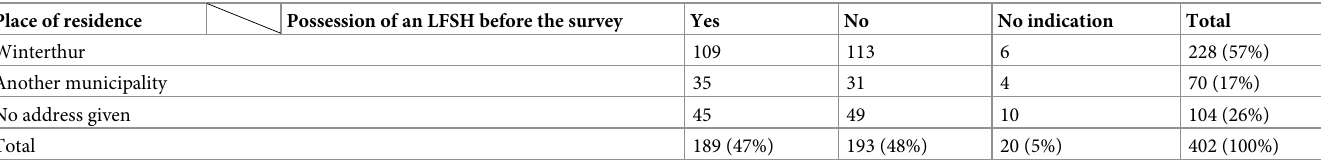
Table 1. Place of residence and possession of an LFSH before the contextualised LFSH intervention. Place of residence Possession of an LFSH before the